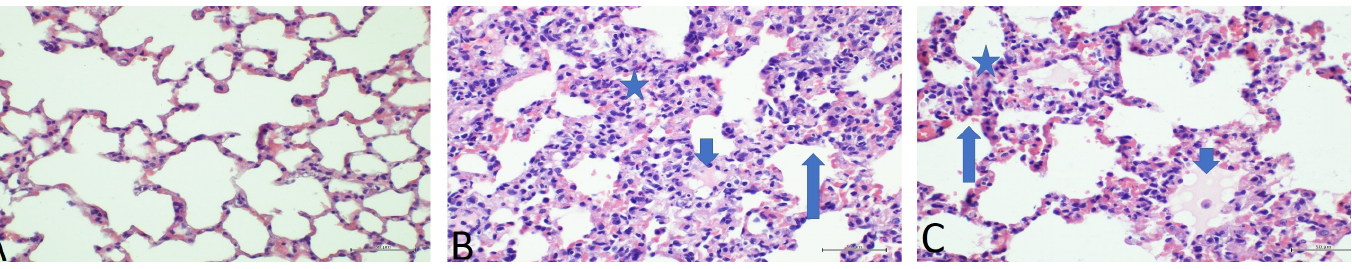
Fig. 6 - Representative histological samples of lung tissue. Photomicrographs of lung tissue samples (400x magnification, H-E staining). A) Control group. B) IR group. C) Probiotic group. The long arrow points to areas of thickened and congested alveolar walls, the short arrow points to intraalveolar fluid and the asterisk points to inflammatory